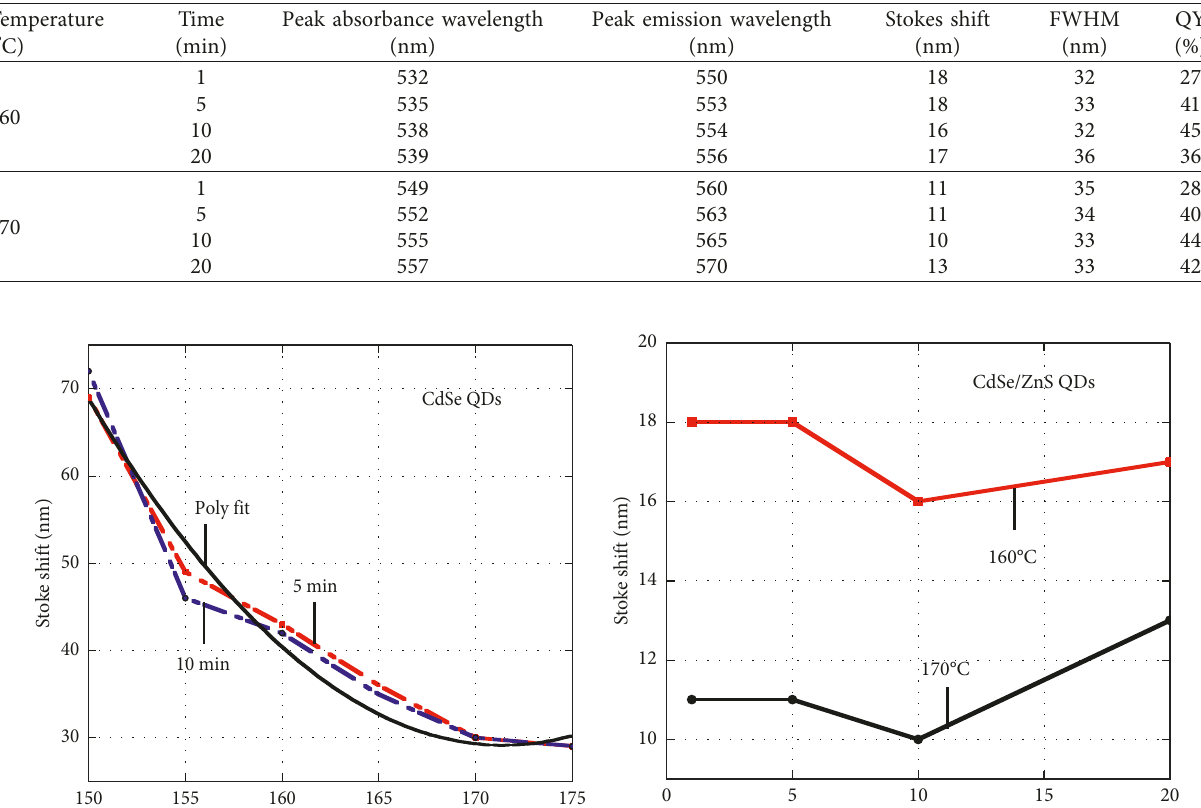
Table 2: Absorption and emission peak intensities, full width at half maximum (FWHM), and quantum yield (QY) of CdSe/ZnS QDs synthesized at 160 ° C and 170 ° C and measured at different reaction times.